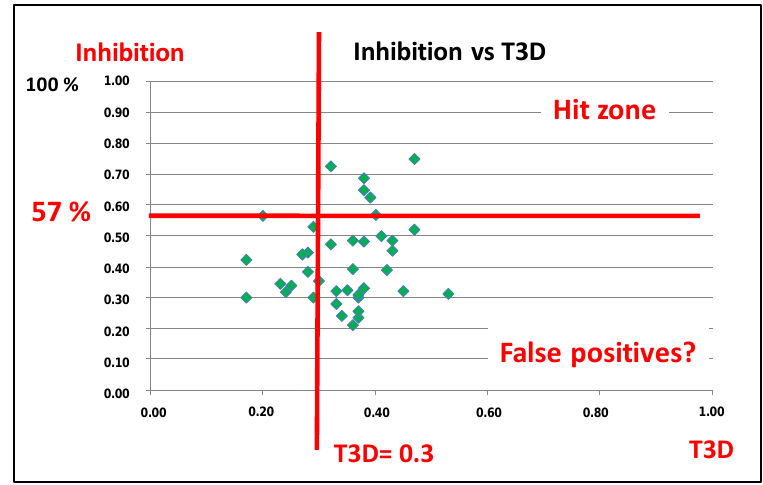
Figure 3. PDE5 inhibition % values were correlated with the T3D values.